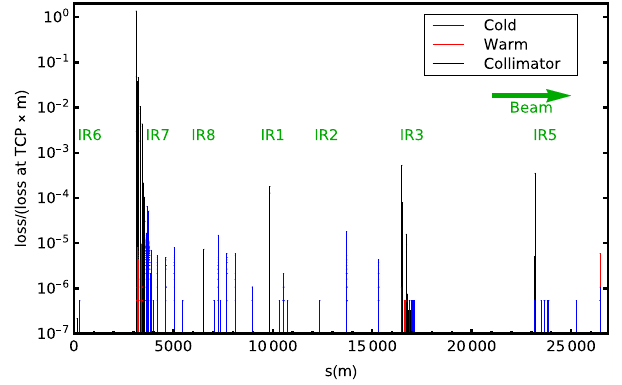
FIG. 8. B1 loss distribution at β (cid:1) ¼ 40 cm around the LHC as simulated with SIXTRACK for an initial excitation in the vertical plane. The values correspond to rates summed over 0.1 m wide bins. The color indicates if the monitor is attached to a cold element (blue), a warm element (red), or a collimator (black).